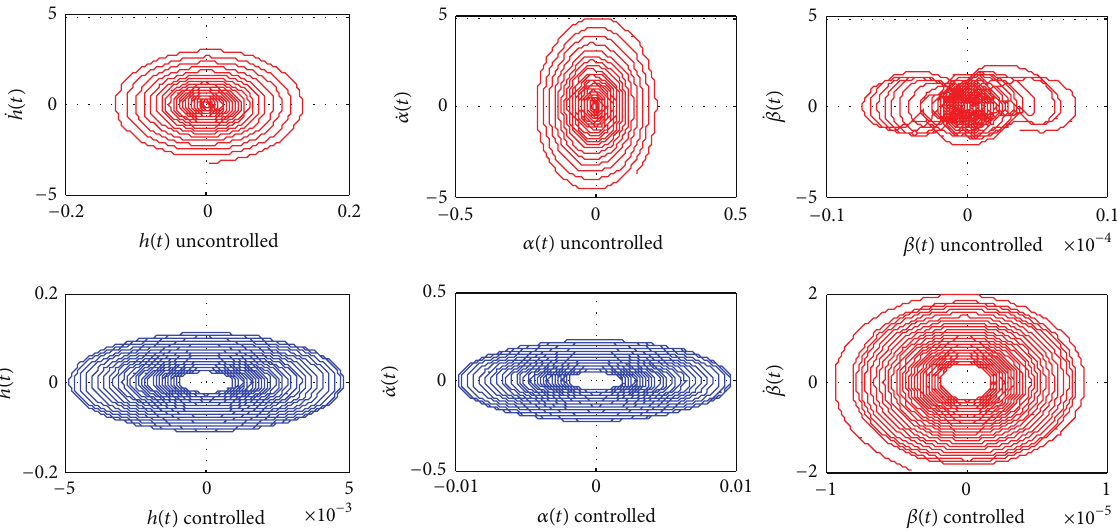
Figure 18: Case 2: phase plan ( |𝛿| = 0.4 ∘ and 𝑉 = 13.1 m/s).